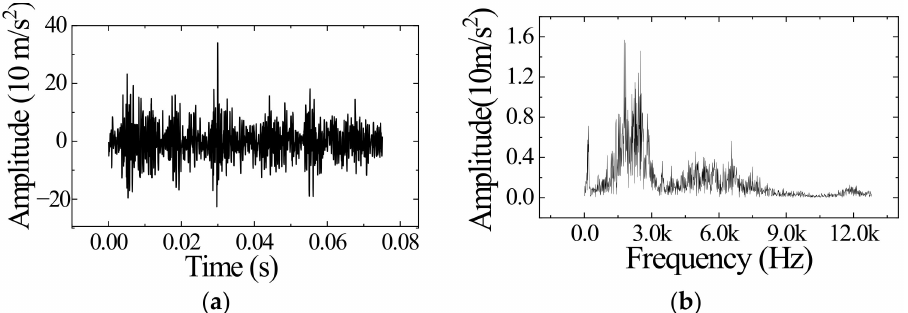
Figure 5. A signal of valve clearance increase at 1600 rpm. ( a ) The signal in time domain. ( b ) The signal in frequency domain.